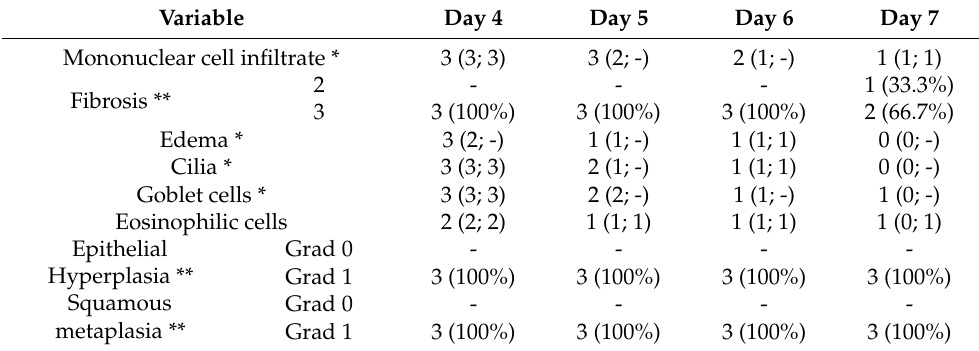
Table 5. Daily evolution after MSC administration–statistical